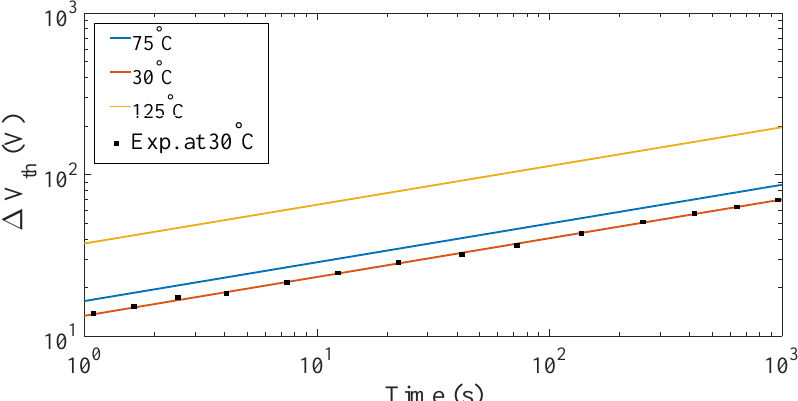
Figure 11. NBTI model results compared with measured data for SiO 2 and Si interface of a MOSFET.